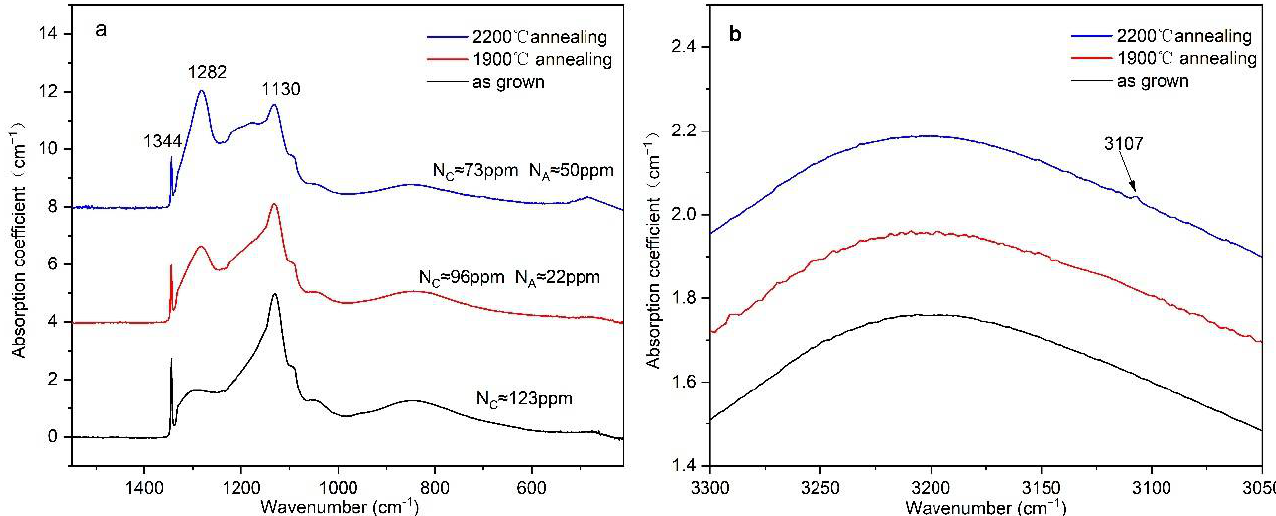
Figure 8. The absorption difference in the infrared region between the as-grown and HPHT-treated synthetic diamonds. In the region of 400–1500 cm −1 ( a ), the peak at 1130 cm −1 decrease gradually and 1282 cm −1 increase; when the nitrogen concentration of A centers is more than C centers, there is a weak absorption peak at 3107 cm −1 ( b ).